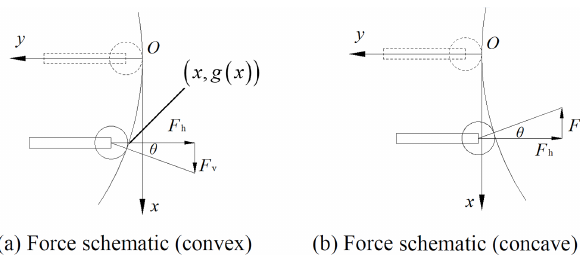
Figure 8. Force schematic of the HSLDS